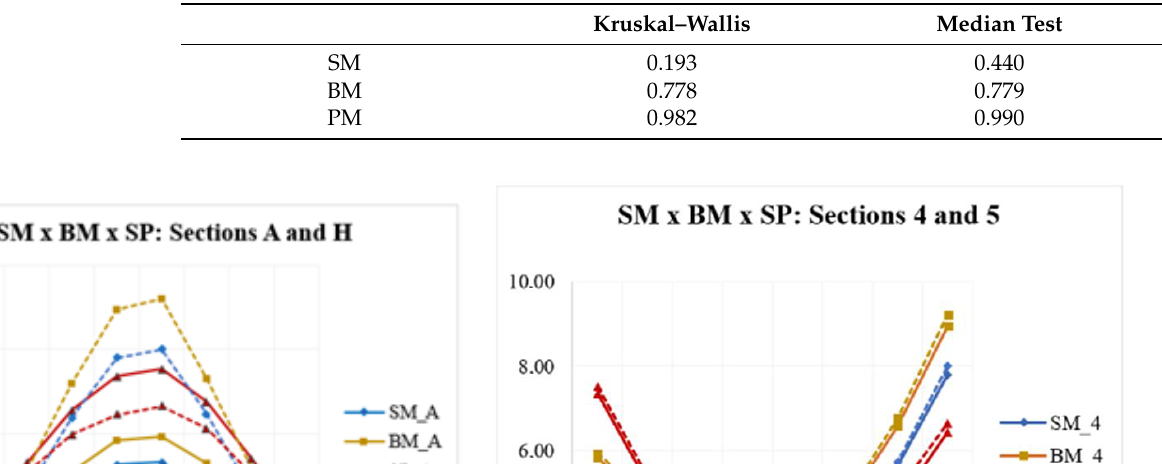
Table 7. p -value for non-parametric tests into groups.